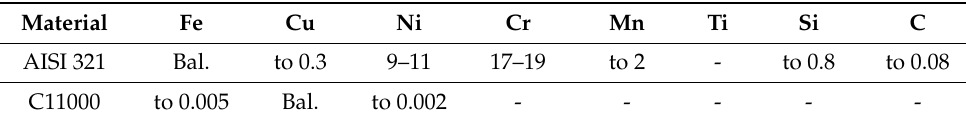
Table 1. Chemical composition of the substrate and filaments used in the wire-feed electron beam additive